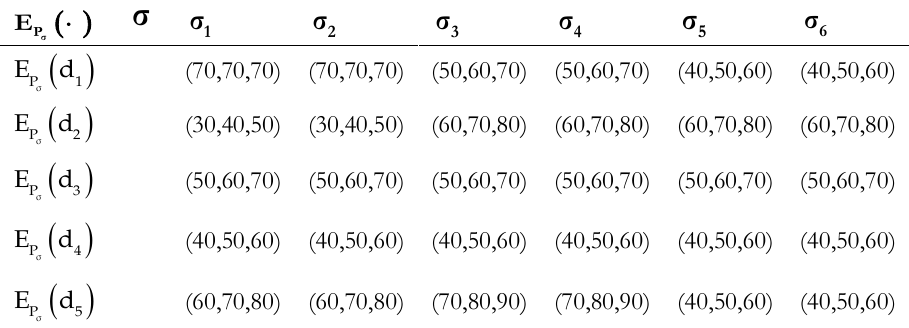
Table 4. Fuzzy expected values